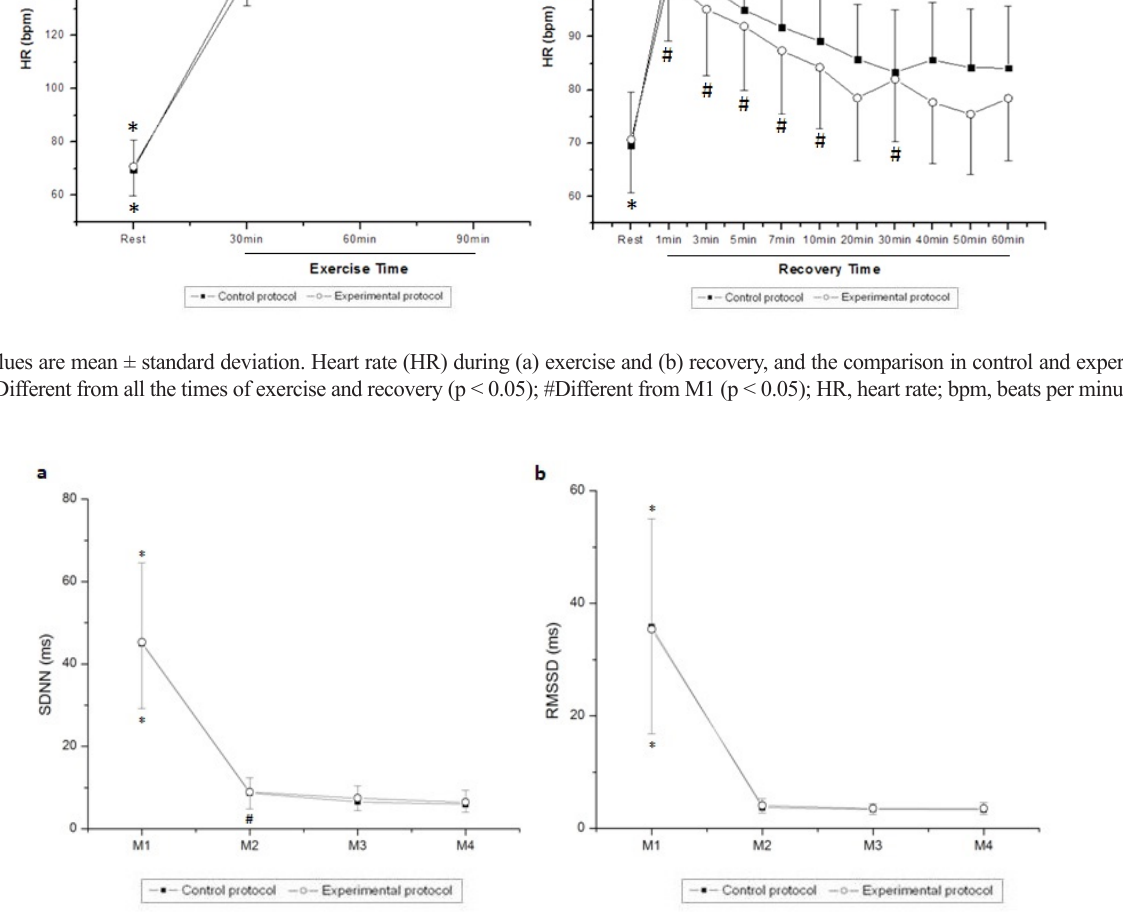
Figure 2. Values are mean ± standard deviation. (a) SDNN and (b) RMSSD during exercise and the comparison in control and experimental protocols. Final 5 minutes of rest (M1) and minutes of exercise: 25–30 (M2), 55–60 (M3), 85–90 (M4). *Different from M2, M3, and M4 (p < 0.05). #Different from M4 in the CP (p < 0.05); SDNN, standard deviation of the mean of all normal RR intervals; RMSSD, square root of the mean squared differences between successive normal RR intervals; M, moment; ms,